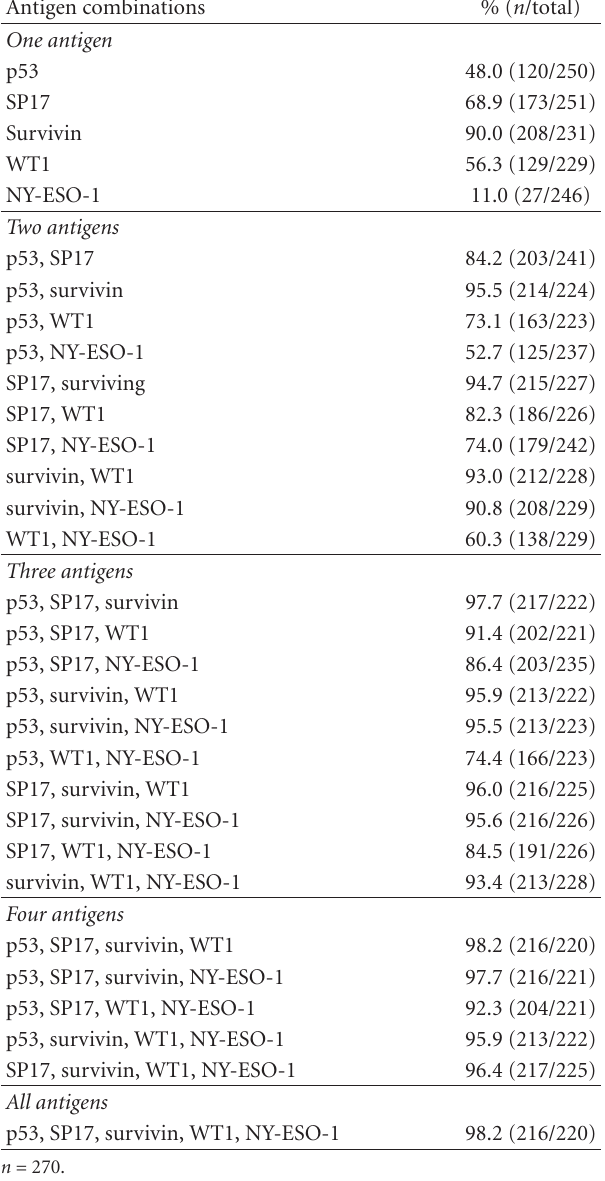
Table 5: Expression of specific antigen combinations in EOC. Antigen